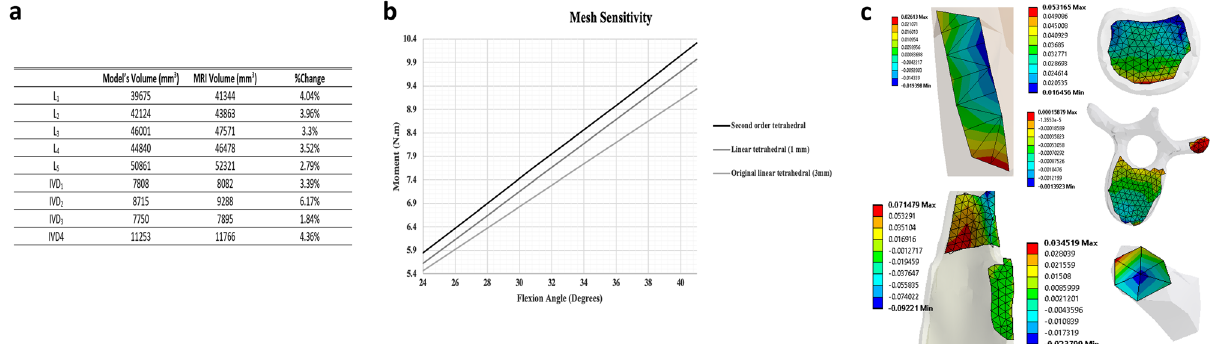
Figure 7. Model’s sensitivity case-studies. ( a ) Model’s form and development sensitivity analysis. ( b ) Model’s sensitivity to different meshes. ( c ) Maximum strain analysis (Conducted and extracted from ANSYS, v.19.1, Canonsburg, Pennsylvania, United States, https ://www.ansys